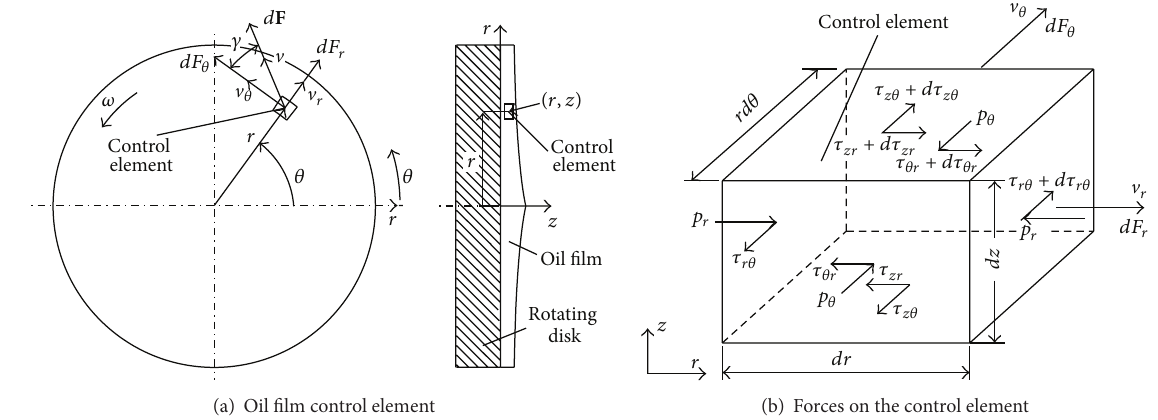
Figure 4: Oil film control element and forces on its